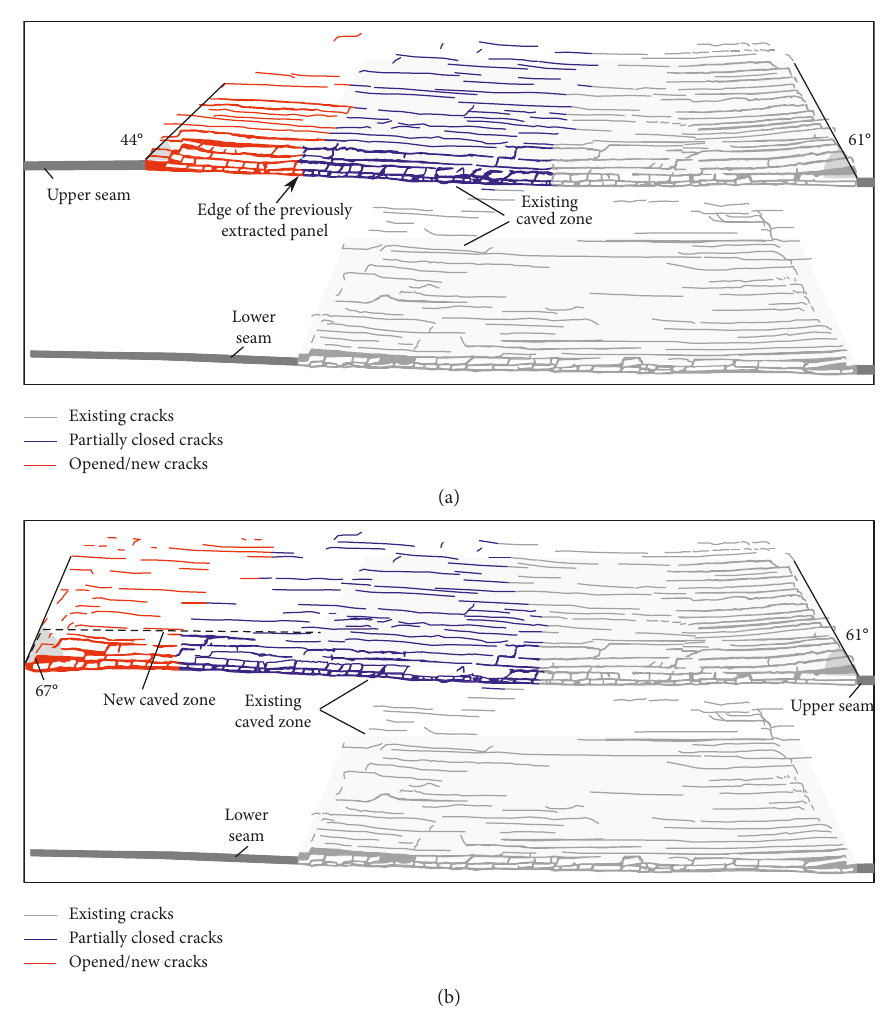
Figure 11: (a, b) Crack propagation after extraction of different segments of the extension part in Case